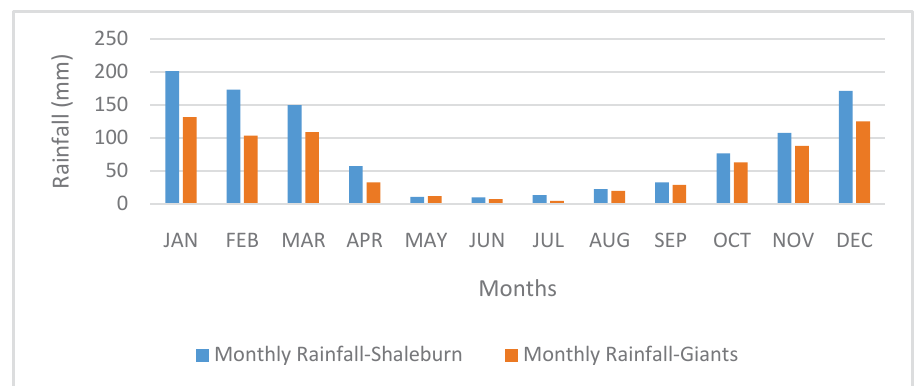
Fig. 9. Plotted monthly rainfall data analysis trend Fig. 8 and 9 depict the plotted mean annual and monthly rainfall data used for this investigation.